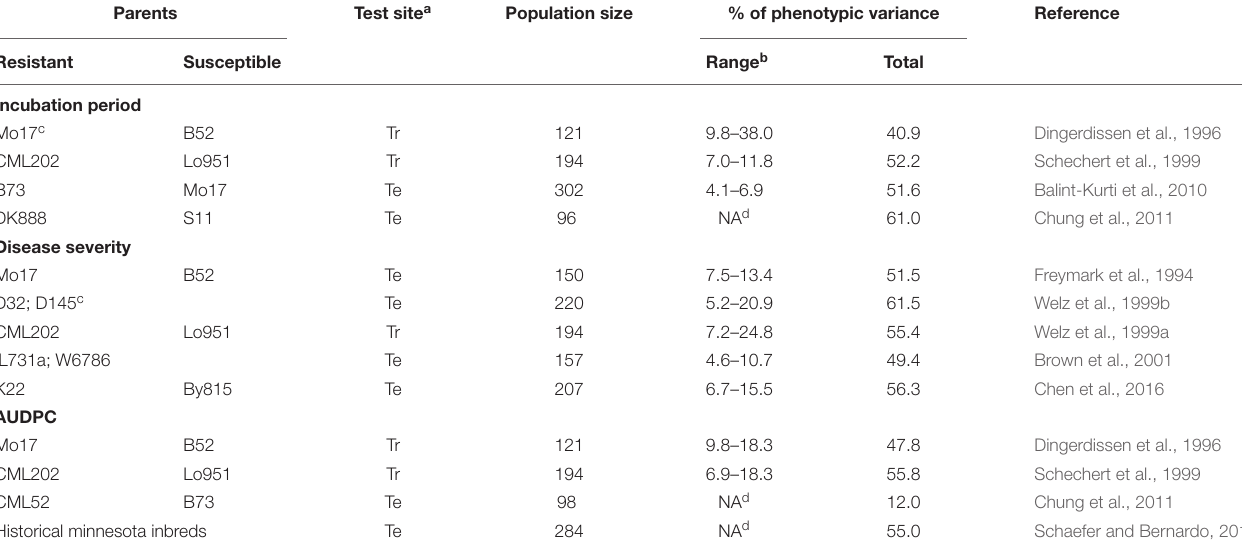
TABLE 3 | Synthesis of some QTL mapping studies using composite interval mapping (CIM). Parents Test site a Population